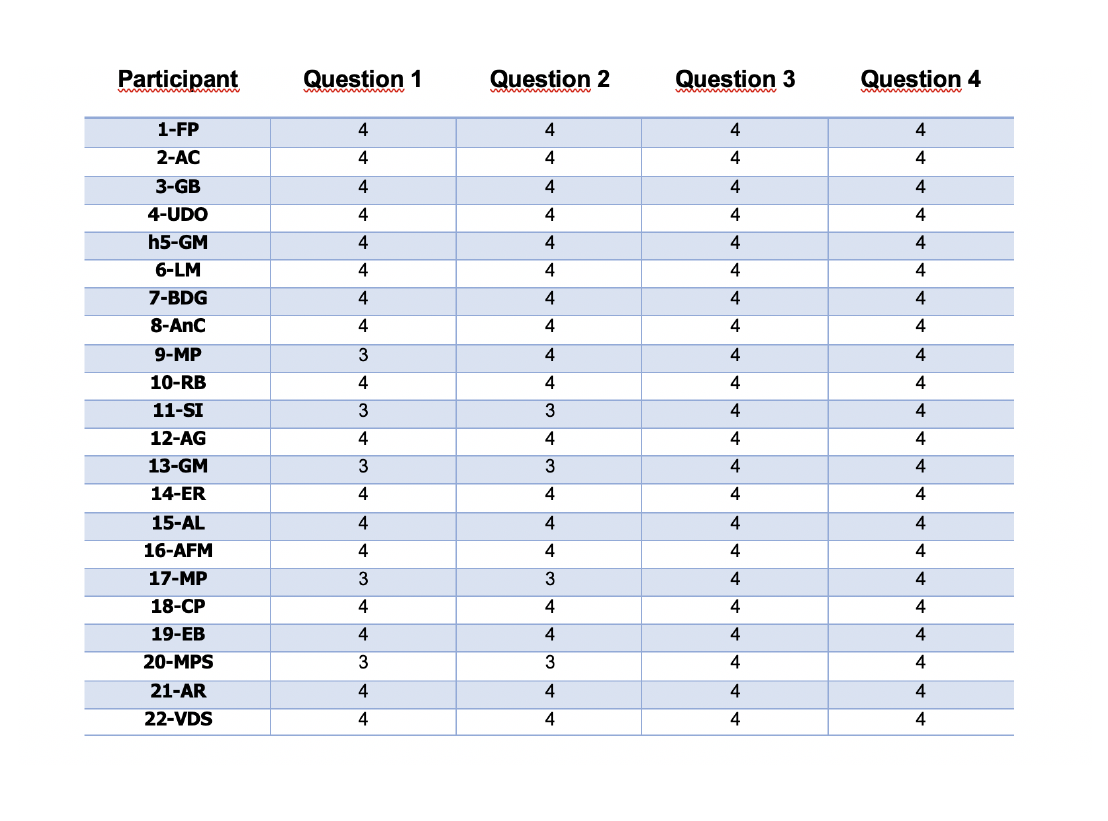
Table 3. Satisfaction